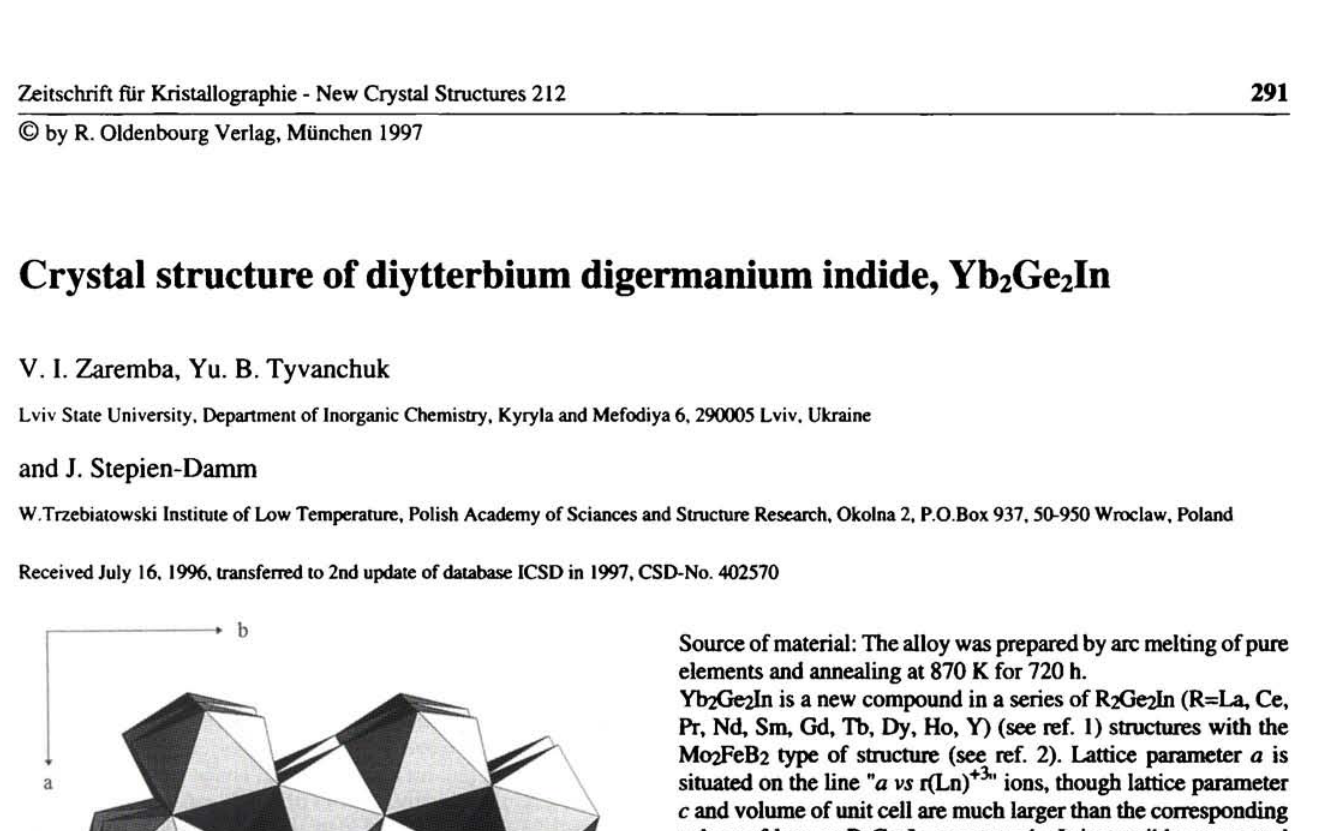
Table 1. Parameters used for die X-ray data collection